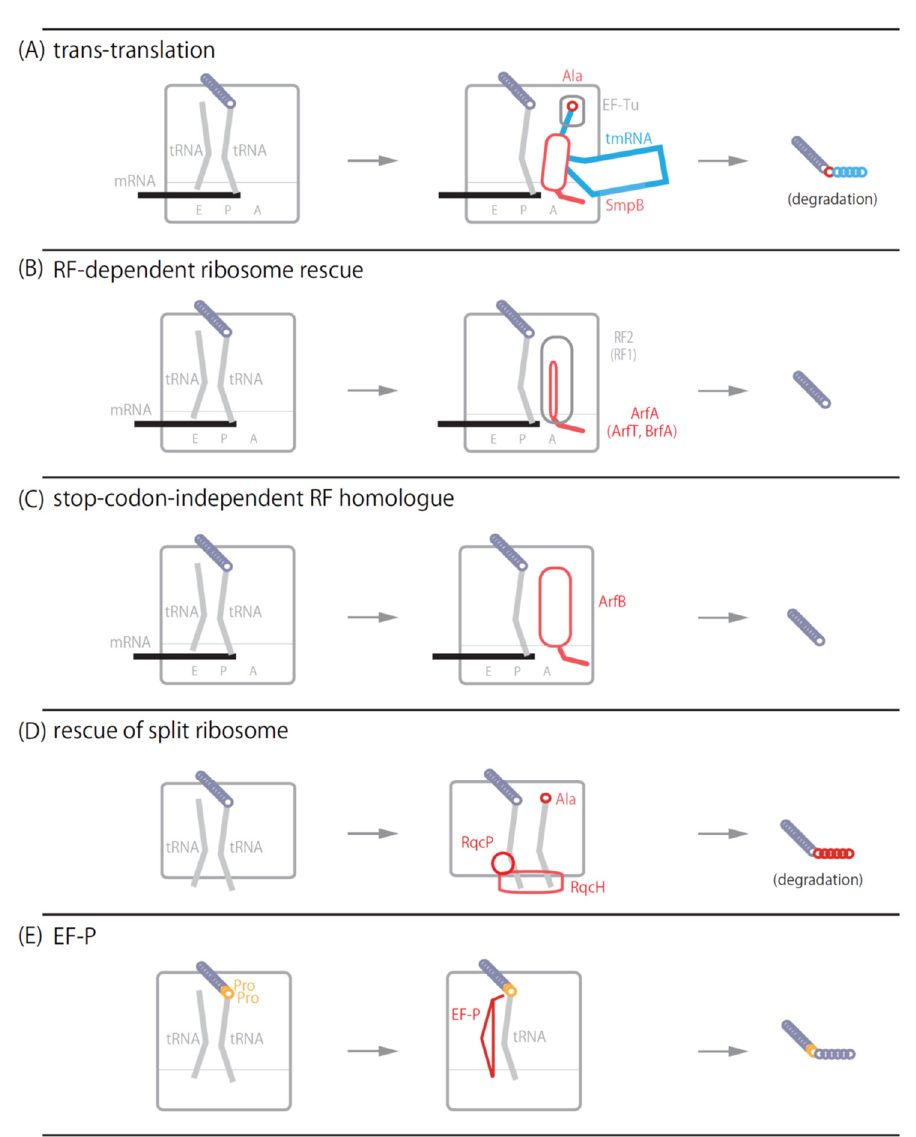
Figure 1. Schematic model of ribosome rescue systems. ( A ) A model of trans -translation. Ala- tmRNA · SmpB · EF-Tu · GTP quaternary complex enters the vacant A-site of the ribosome stalled on nonstop mRNA. Ala-tmRNA · SmpB receives the nascent polypeptide from the P-site peptidyl-tRNA and adds several amino acids to the C-terminus of the polypeptide as the degradation tag. ( B ) A model of RF-dependent ribosome rescue. ArfA, ArfT or BrfT with release factor RF2 (RF1 is also available in Francisella tularensis ArfT) binds to the ribosome stalled on nonstop mRNA to hydrolyze the ester bond between nascent polypeptide and P-site tRNA. ( C ) A model of stop codon-independent RF homologue. ArfB binds to the ribosome stalled on nonstop mRNA to hydrolyze the P-site peptidyl- tRNA. ( D ) A model of RqcH-RqcP system. RqcH and RqcP bind to the 50S subunit-peptidyl-tRNA complex. RqcH and RqcP adds poly-alanine tag to the C-terminus of nascent polypeptide as